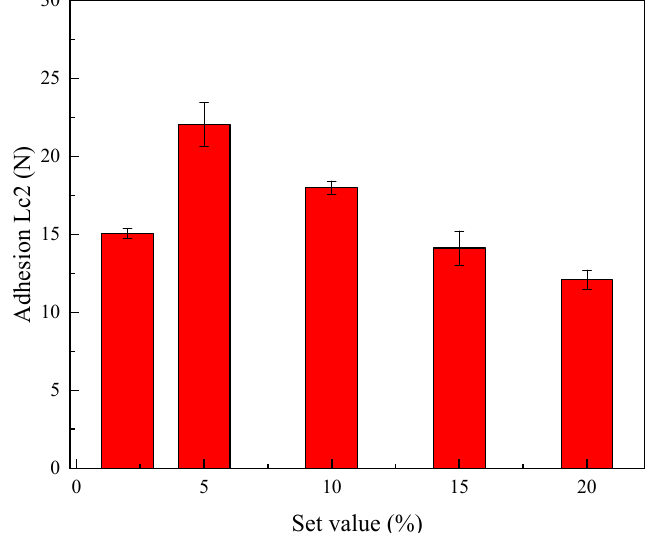
Figure 10. Adhesion of the Cr-DLC films deposited at different set values.